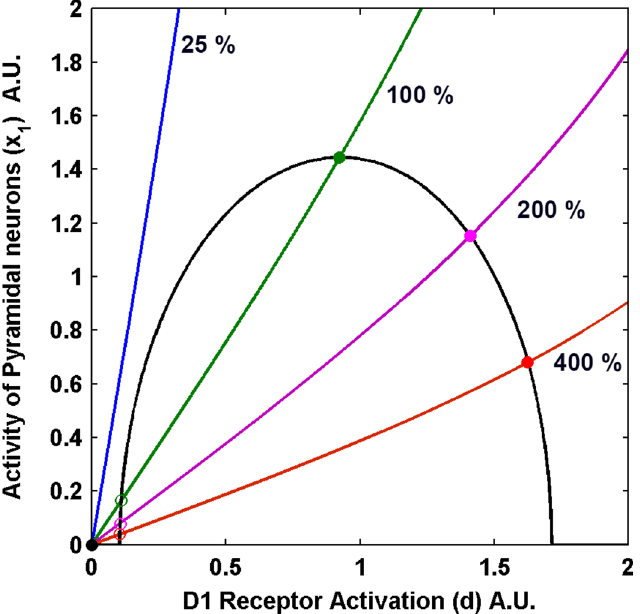
Fig 2. Nullcline Plots of the Pyramidal Neurons Activity, x 1 versus D1 Receptor Activation, d for different values of dopamine releasability, W 34 . W 34 is indicated by the % values relative to 0.36. The solid (open) circles represent stable (unstable) fixed points. The intersection points of the curves are the points of global equilibrium of the system, for that particular W 34 . The parameters used here are t 1 ¼ 20 ; t (cid:4) 2 ¼ 6 : 8 ; t 3 ¼ 10 ; t 800 and W (cid:4) 0 : 5588 , W (cid:4) 0 : 786 , W W a = 0.15. 4 ¼ 13 = 0.023, 21 = 0.339, 11 ¼ 12 ¼